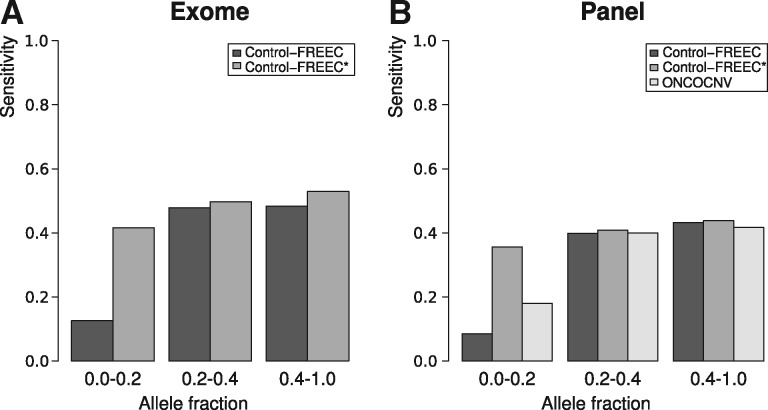
Average sensitivity of Control-FREEC and ONCOCNV in relation to SCNA allelic fraction, computed over all samples. Because the tumors were heterozygous, very few variants had an allele fraction above 0.5. Therefore all variants with an allele fraction above 0.4 were binned into one class. (A) Exome and (B) targeted gene panel data. * Control-FREEC with anticipated admixture level set as parameter. For ONCOCNV, the parameter settings did not influence the sensitivity; therefore only results for default parameters are shown